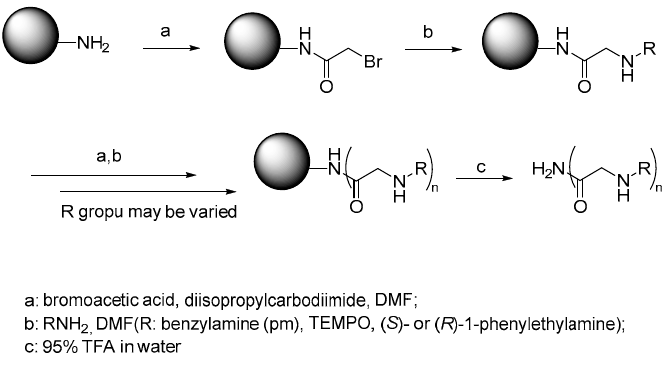
Figure 3. Monomeric units incorporated into the catalytic peptoids.